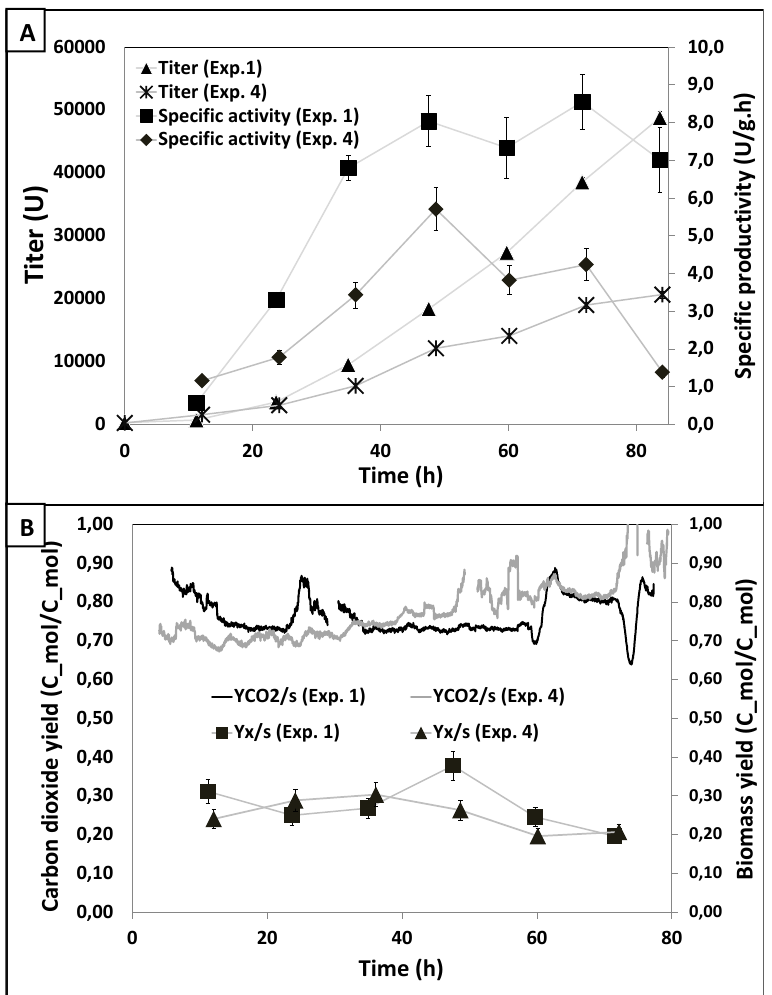
Figure 2. ( A ) Specific productivity and titer in experiments 1 and 4 (Exp. 1 and Exp. 4). ( B ) Biomass and carbon dioxide yield in experiments 1 and 4 (Exp. 1 and Exp.